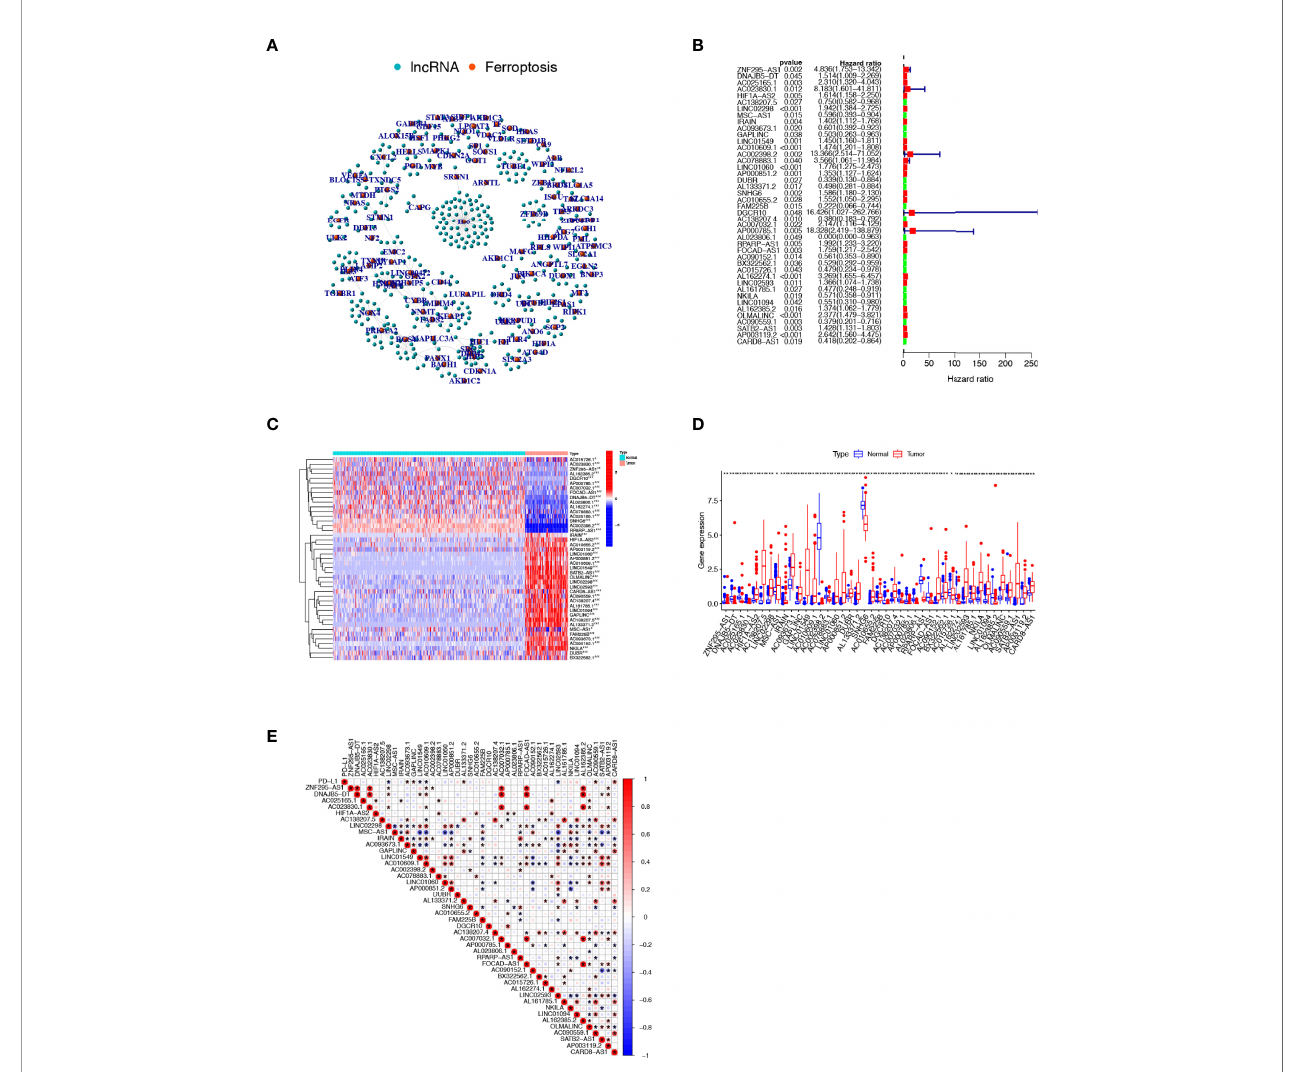
FIGURE 2 | Comprehensive analysis of prognosis-related FRLs in osteosarcoma . (A) Co-expression network of FRGs and FRLs. (B) Identi fi cation of candidate prognosis-associated FRLs using univariate Cox regression analysis. (C, D) Heatmap (C) and boxplot (D) showing the expression level of prognosis-related FRLs. (E) correlation between prognosis-related FRLs and PD-L1 expression. FRGs, ferroptosis-related genes; FRLs, ferroptosis-related lncRNAs. *p < 0.05, **p < 0.01, *p <